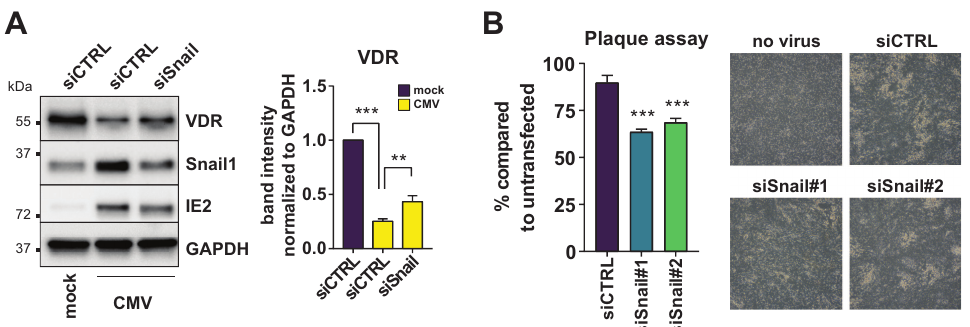
Figure 5. Snail ablation restores VDR expression. ( A ) VDR and Snail protein expression was deter- mined in lysates of HFF transfected with a non-targeting control siRNA or Snail1 specific siRNA and harvested at 24 h p.i. Representative blot (left) and quantification of bands from multiple experiments relative to the GAPDH loading control (right). Asterisks show significant differences to the CMV siCTRL control sample as determined by ANOVA Dunnett’s multiple comparison post-hoc test. ( B ) Plaque assay showing the percentage of plaques in siRNA-transfected cells compared to an un- transfected control. Asterisks show significant differences in two different Snail-targeting siRNAs to the CMV siCTRL control sample as determined by ANOVA Dunnett’s multiple comparison post-hoc test. Light microscope pictures of representative areas are shown on the